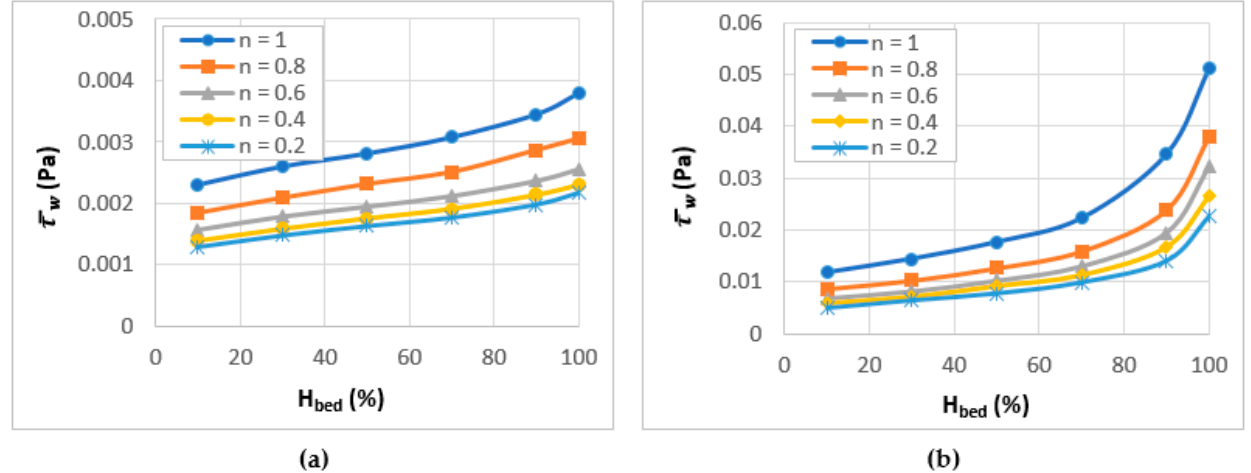
Figure 6. Wall shear stress vs. bed height for conditions e = 0.9 and 𝑸 = 5 × 10 − 5 m 3 /s and different diameter ratios: ( a ) 𝜿 = 0.25; and ( b ) 𝜿 = 0.75.